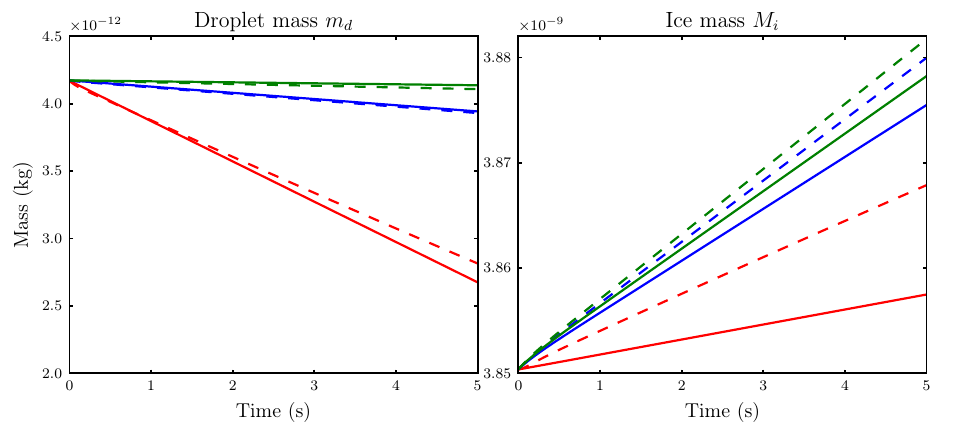
Figure 5. As in Fig. 4, but for the case of N d = 38 droplets per influence